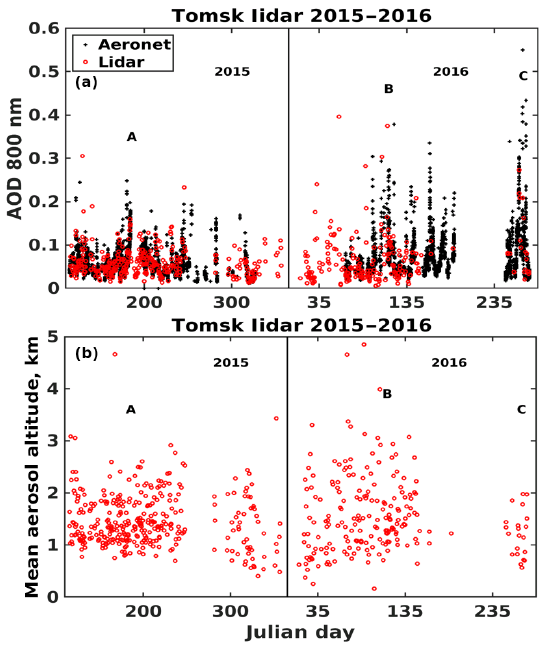
Figure 8. Time evolution from April 2015 to September 2016 of the 808nm AOD for lidar (red) and sun-photometer (black) ob- servations (a) and corresponding aerosol altitudes z aer given by Eq. (2) (b) . A, B, and C are the cases analysed in Sect.